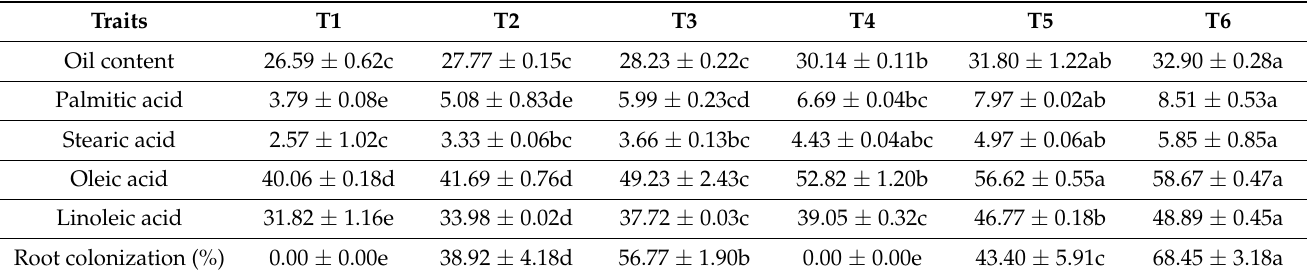
Table 3. Effects of different treatments on various biochemical characteristics and root colonization (%) of